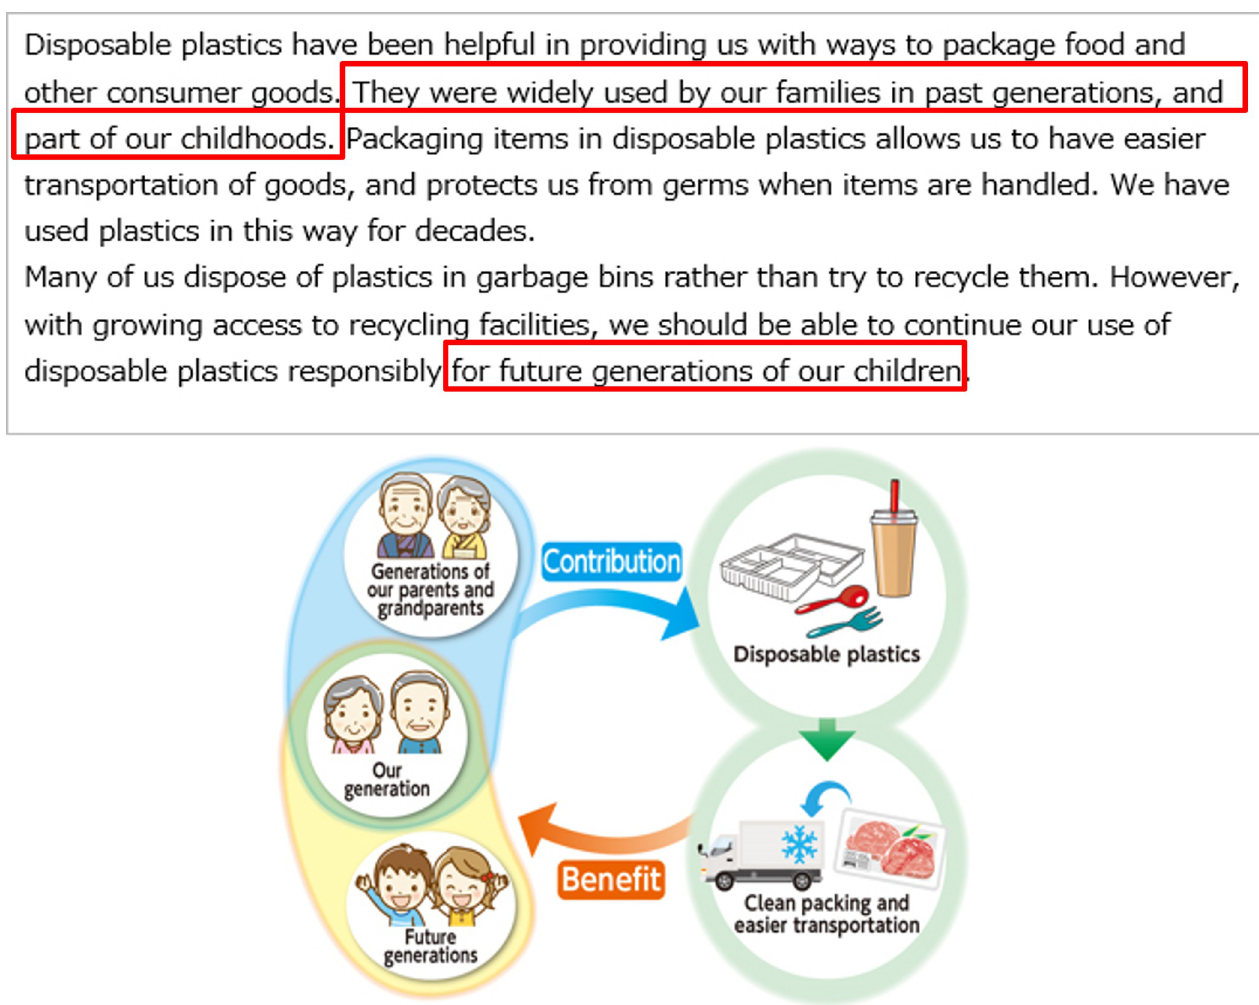
Fig 6. Message presented to those 50 years of age and older in treatment group 2. The intervention is highlighted with red rectangles.